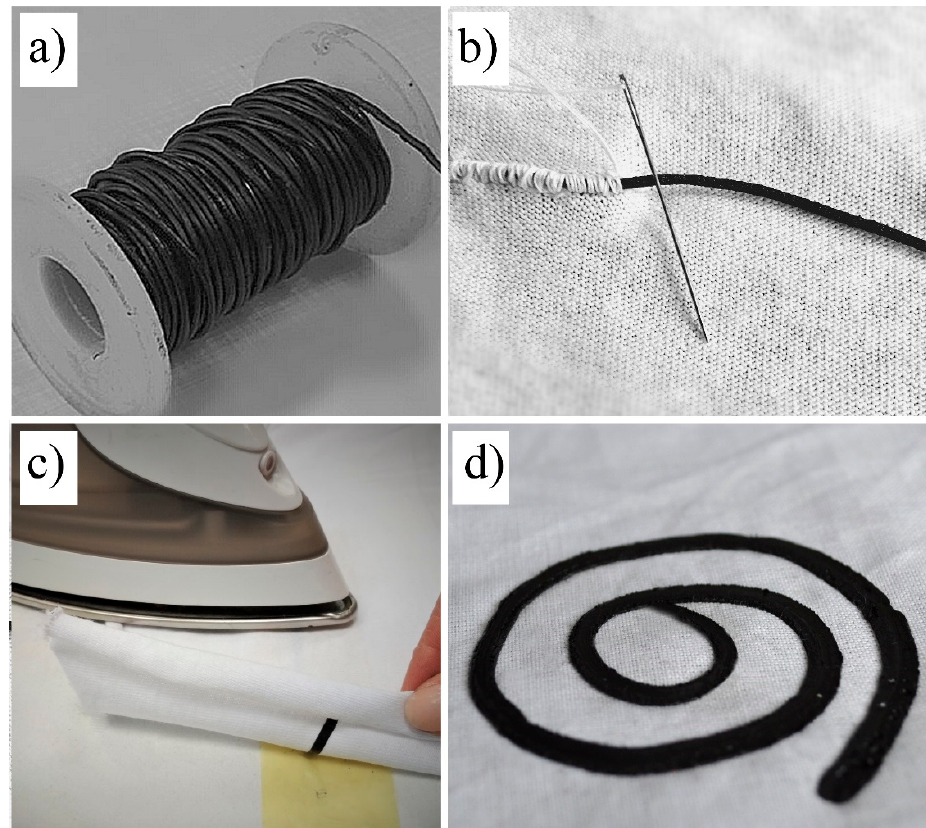
Figure 6. Composite CNT/TPU fiber: ( a ) Wound on a reel; ( b ) sewn into fabric; ( c ) and ( d ) ironed onto fabric.